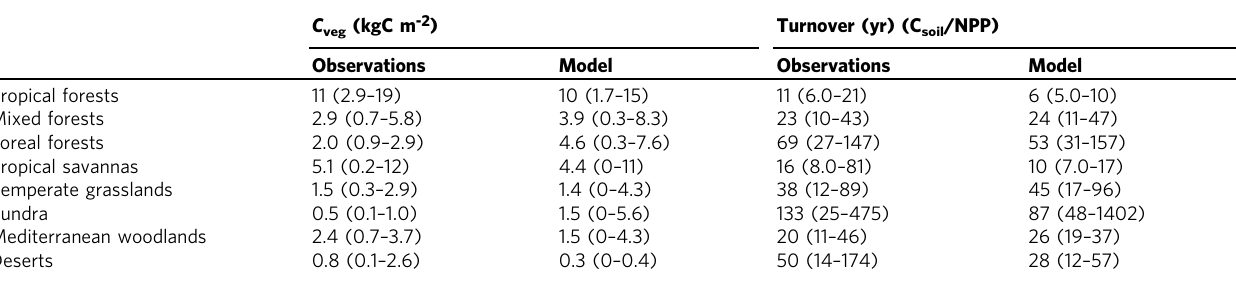
Table 2 Evaluation of carbon stored in vegetation ( C veg ) and turnover times (de fi ned as soil carbon, C soil , divided by net primary productivity, NPP) in the model in the year